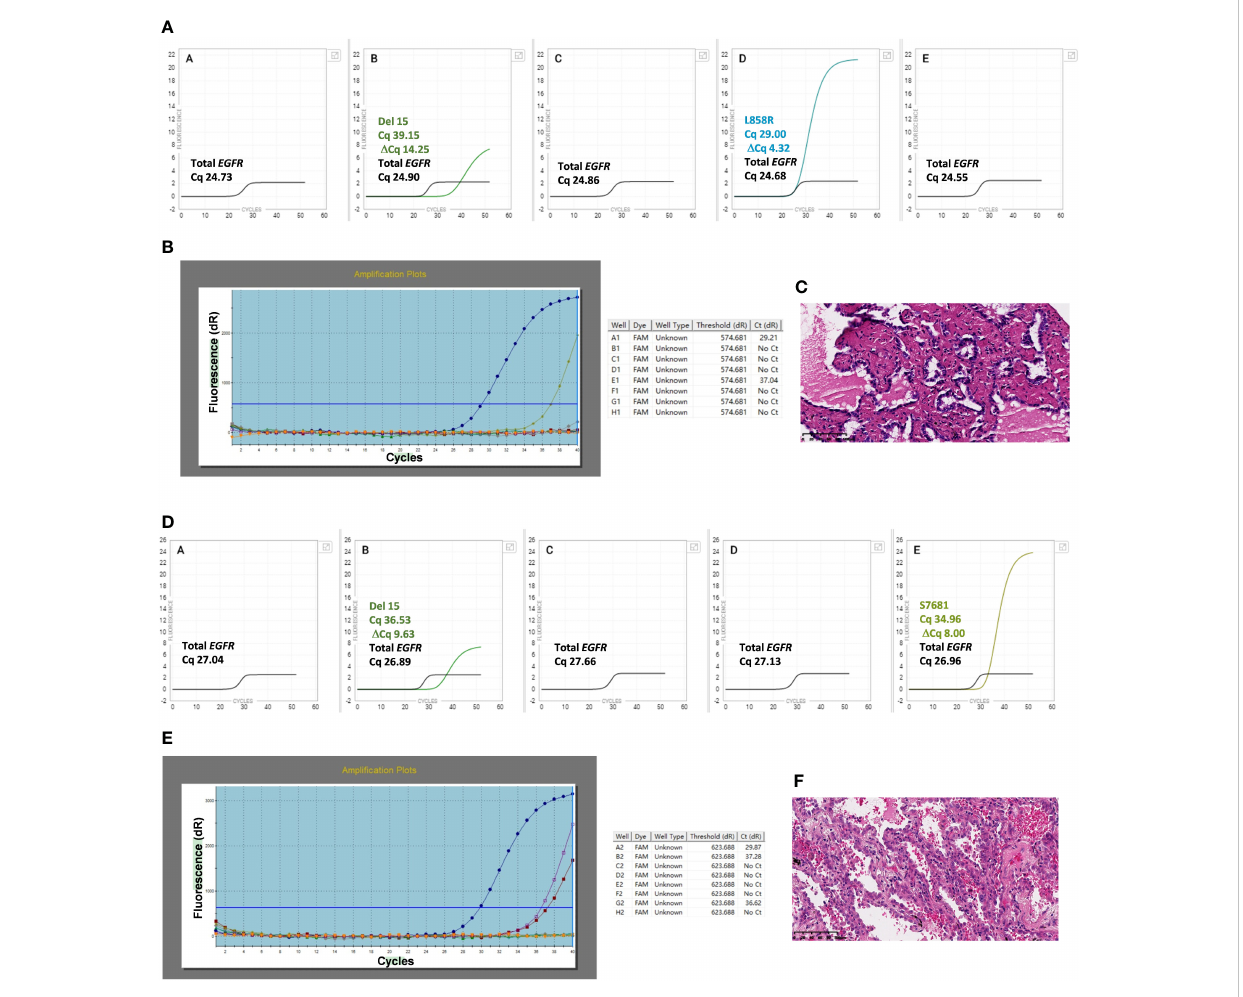
FIGURE 3 Idylla ™ Explore version 2.5.1294.1 (Biocartis, Mechelen, Belgium) default display showing the detail of PCR curves and cycle of quanti fi cation (Cq) values of sample 88# (3A) and samples 91# (3D) . Cq values are label for the sample processing controls, EGFR Total, and the target for which a signal has been detected (default view). Panels A to E in the image represent the fi ve PCR chambers in the Idylla ™ cartridge. Details of PCR curves and Cycle threshold (Ct) values by ARMS-PCR for samples 88# (3B) and 91# (3E) . Ct value of well A is available for the quality control of DNA input, and Ct values of the other wells are for the target sequences detected. The H&E photos of samples 88 and 91 are displayed in (3C, 3F)